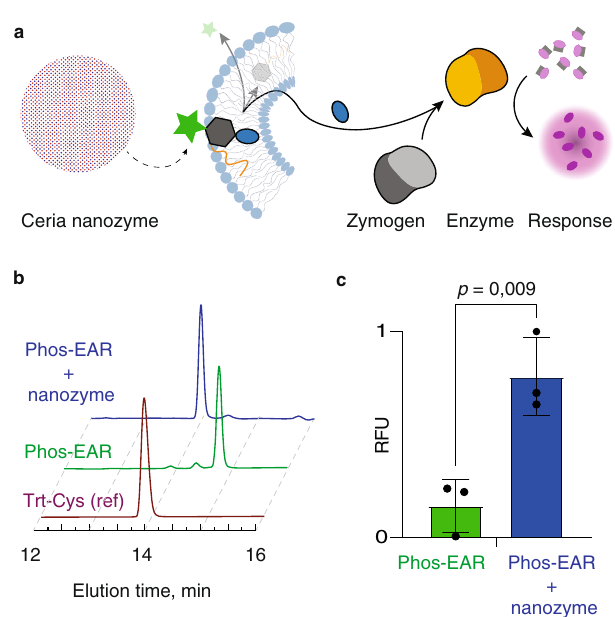
Fig. 6 | Inhibition of signaling by thiol traps. a Schematic illustration for thiol inhibition by N-ethylmaleimide (Ethyl-Mal) or PEG maleimide (PEG 5kDa -Mal) in the internal and external solution, the lipid bilayer, and/or within the liposome lumen. b Fluorescenceintensityinsolutionsofliposomesthatcontainthepapainzymogen andtheproteasesubstrateArg-AMC;zymogenreactivationisperformedbyDTT,L- Cys, or Phos-EAR upon addition of ALP; zymogen reactivation is performed in the presence of N-ethylmaleimide (orange) or PEG 5kDa maleimide (purple) or no mal- eimide (blue). Concentration of DTT, L-Cys, and Phos-EAR was 10 µ M, and of the